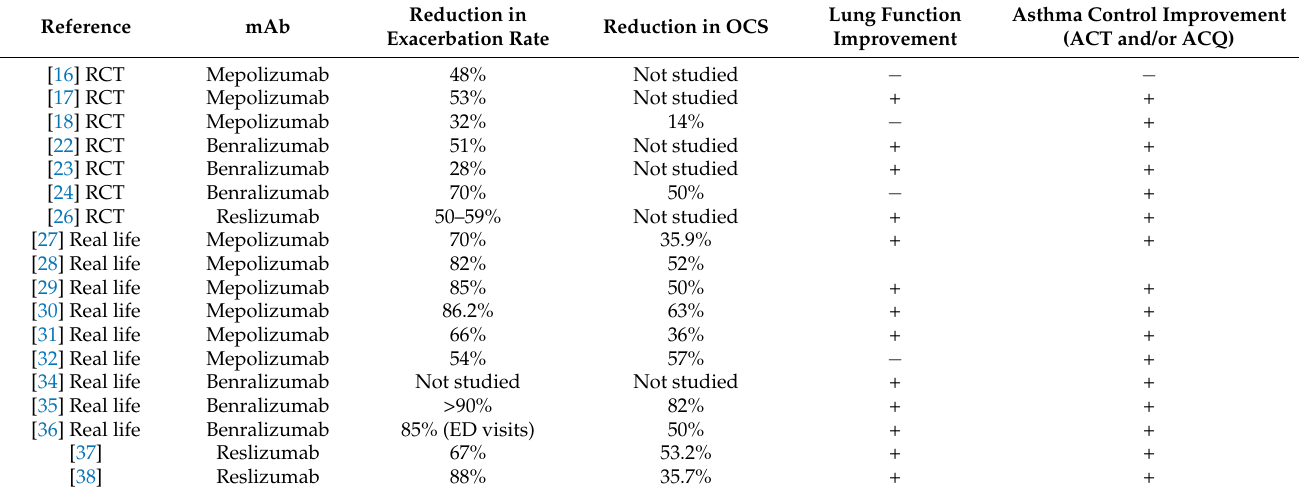
Table 1. Anti-IL-5/IL-5R monoclonal antibodies effects. Abbreviations used: OCS: oral corticosteroids, ACT: asthma control test, ACQ: asthma control